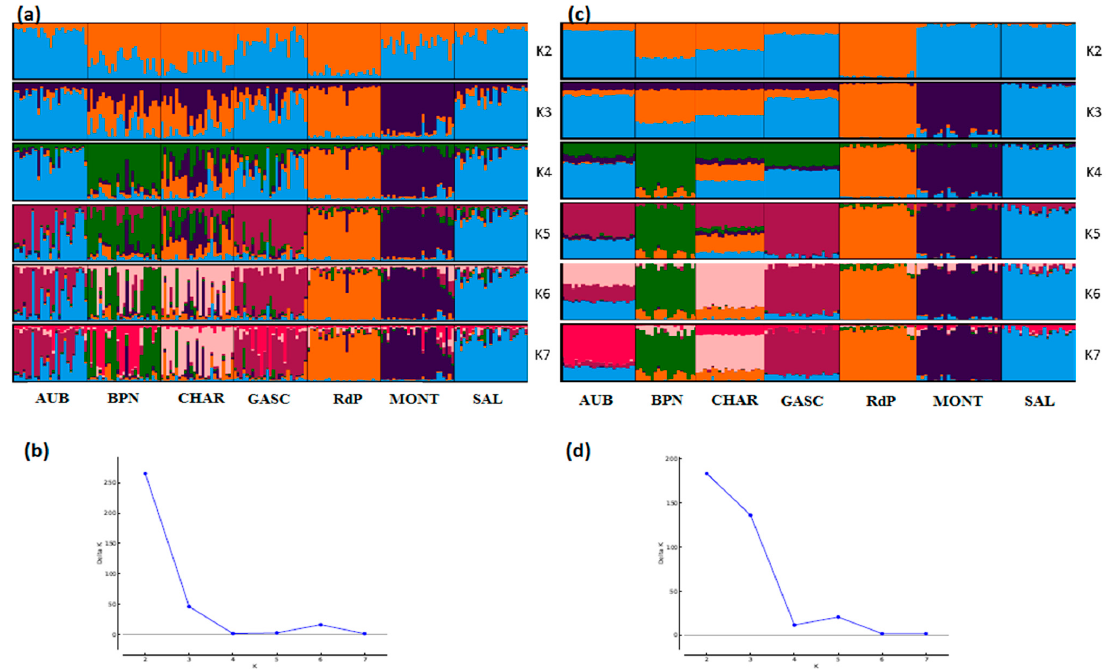
Figure 6. Genetic structure of French cattle breeds by Bayesian analysis (K = number of clusters). ( a ) STRUCTURE plot obtained from the microsatellite dataset; ( b ) graph showing Δ K calculated according to [42] for the microsatellite dataset; ( c ) STRUCTURE plot obtained from the SNP dataset; ( d ) graph showing Δ K calculated according to [42] for the SNP dataset. For breed names see codes in